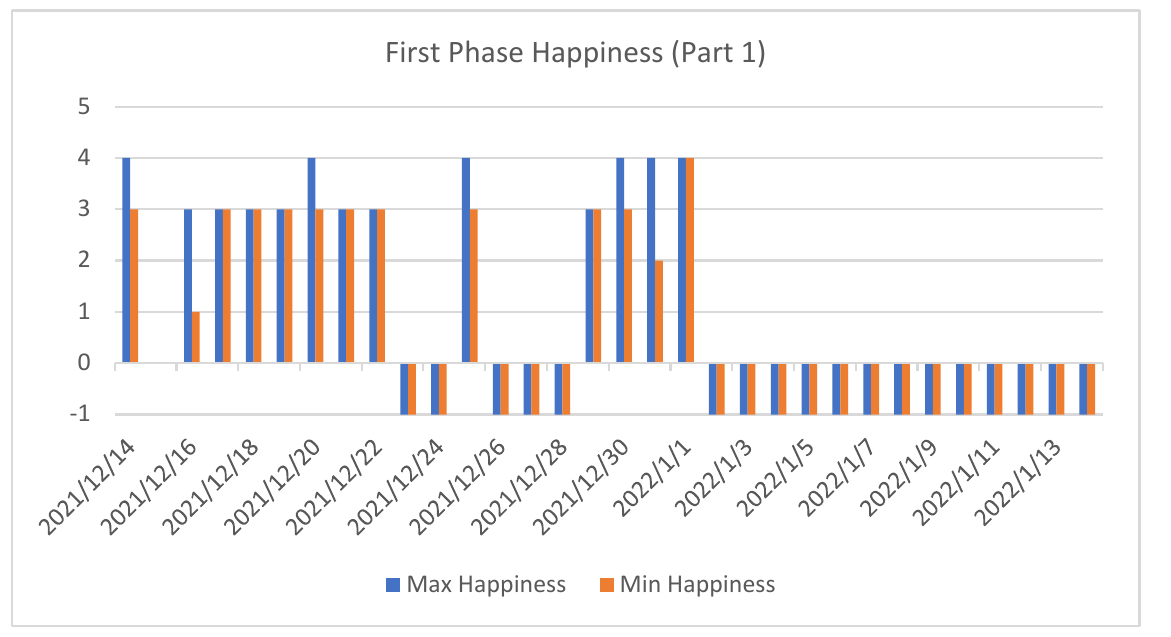
Figure 13. Duration of sessions recorded with the Empatica E4 medical device for the first subject.